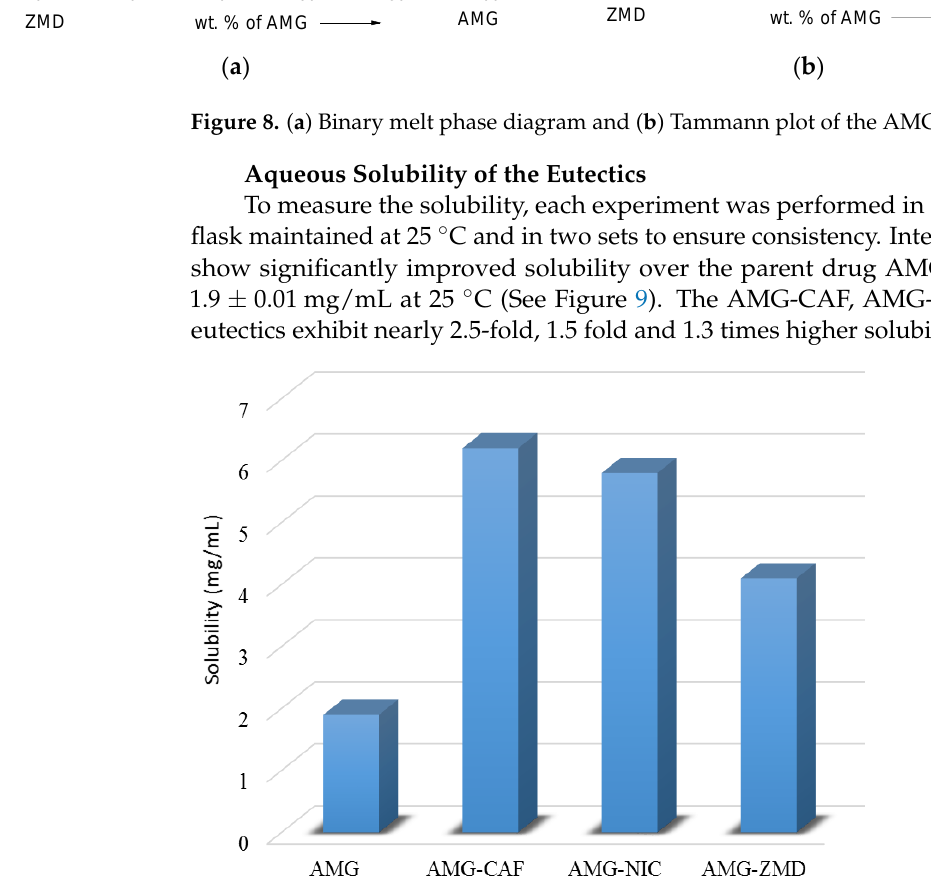
Figure 9. Comparison of solubilities of AMG and its eutectic mixtures in water at 25 ◦ C. Different thermodynamic parameters like melting temperature depression and the heat of fusion ( ∆ H f ) can affect the overall solubility [27,28]. Considerable decrease in the ∆ H f (see Table 1) is observed for the AMG-CAF system and expectedly it is showing higher solubility than the AMG. However, higher ∆ H f has been observed for the eutectics AMG-ZMD and AMG-NIC, and as a result, the solubility difference is not significant. Particularly, despite having higher soluble coformer NIC, the eutectic AMG-NIC exhibited less solubility compared to AMG-CAF. The experimental solubility results are supported by the ideal solubility data for the eutectic mixtures calculated by using the van’t Hoff equation (Figure S2, Supporting Information), showing similar trends for the solubilities. Moreover, the precipitates obtained from the solubility experiment were further evaluated by PXRD measurements, which are presented in Figure S3 (Supporting Information). The PXRD patterns observed from the eutectics before and after solubility evaluations